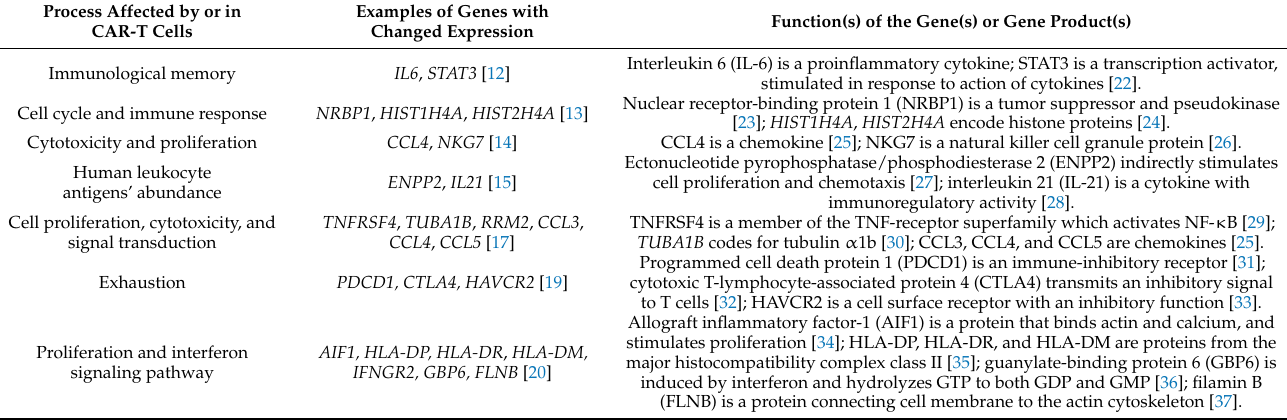
Table 1. Processes modified by/in CAR-T cells as determined by